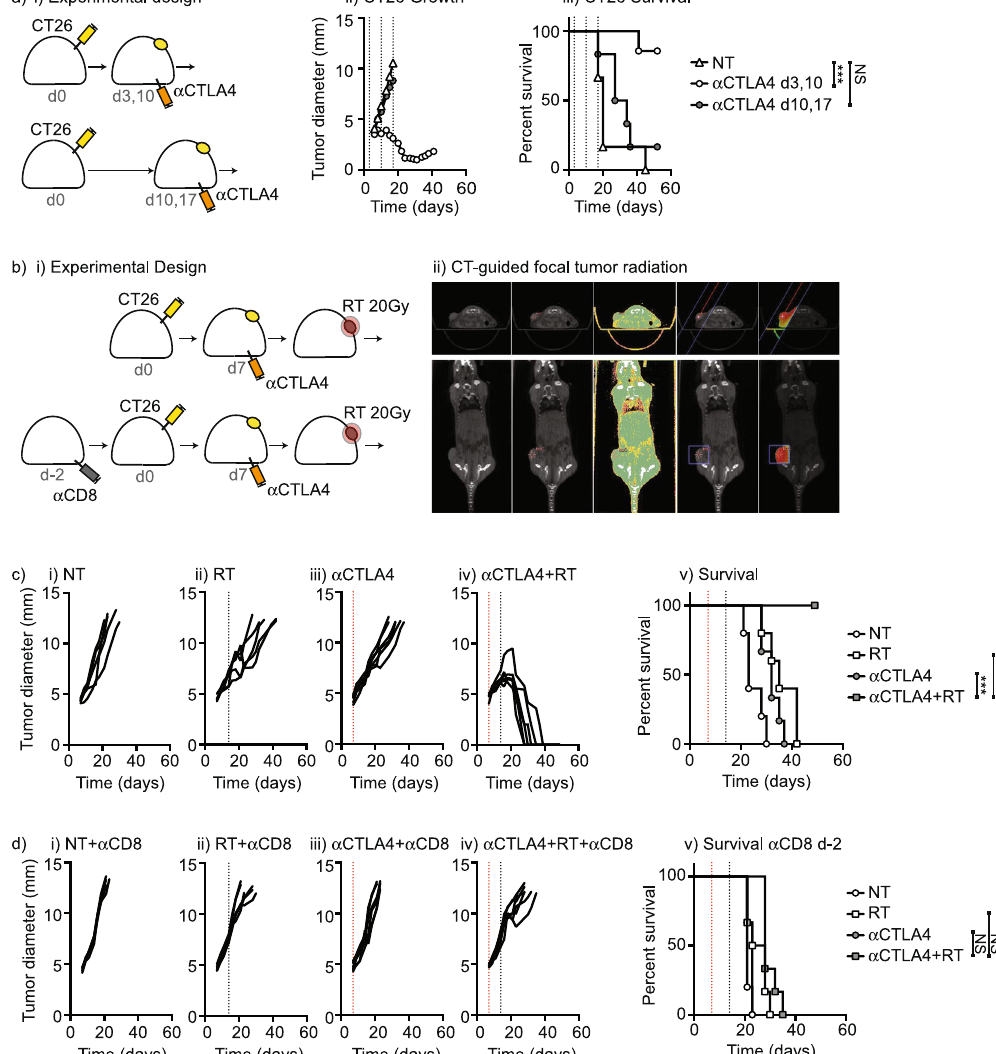
Figure 1. The addition of radiation therapy permits control of tumors after checkpoint failure that is dependent on CD8 T cells at tumor implantation. ( a ) BALB/c mice were implanted with CT26 tumors and left untreated (NT) or treated with anti-CTLA4 on d3 and d7, or on d7 and d14. Graphs show i) Average tumor size and ii) survival. ( b ) i) BALB/c mice were randomized to receive CD8 depleting antibodies 2 days prior to implantation with CT26 tumors, and groups randomized to receive anti-CTLA4 on d7 and radiation therapy on d14. ii) Radiation therapy was delivered using CT guidance to deliver a focal therapeutic dose of 20 Gy with minimize dose to radiosensitive structures. Graphs show growth and survival of individual tumors in ( c ) control treated and ( d ) anti-CD8 treated mice. Key: * p < 0.05; ** p < 0.01; *** p < 0.001; **** p < 0.0001; NS = not